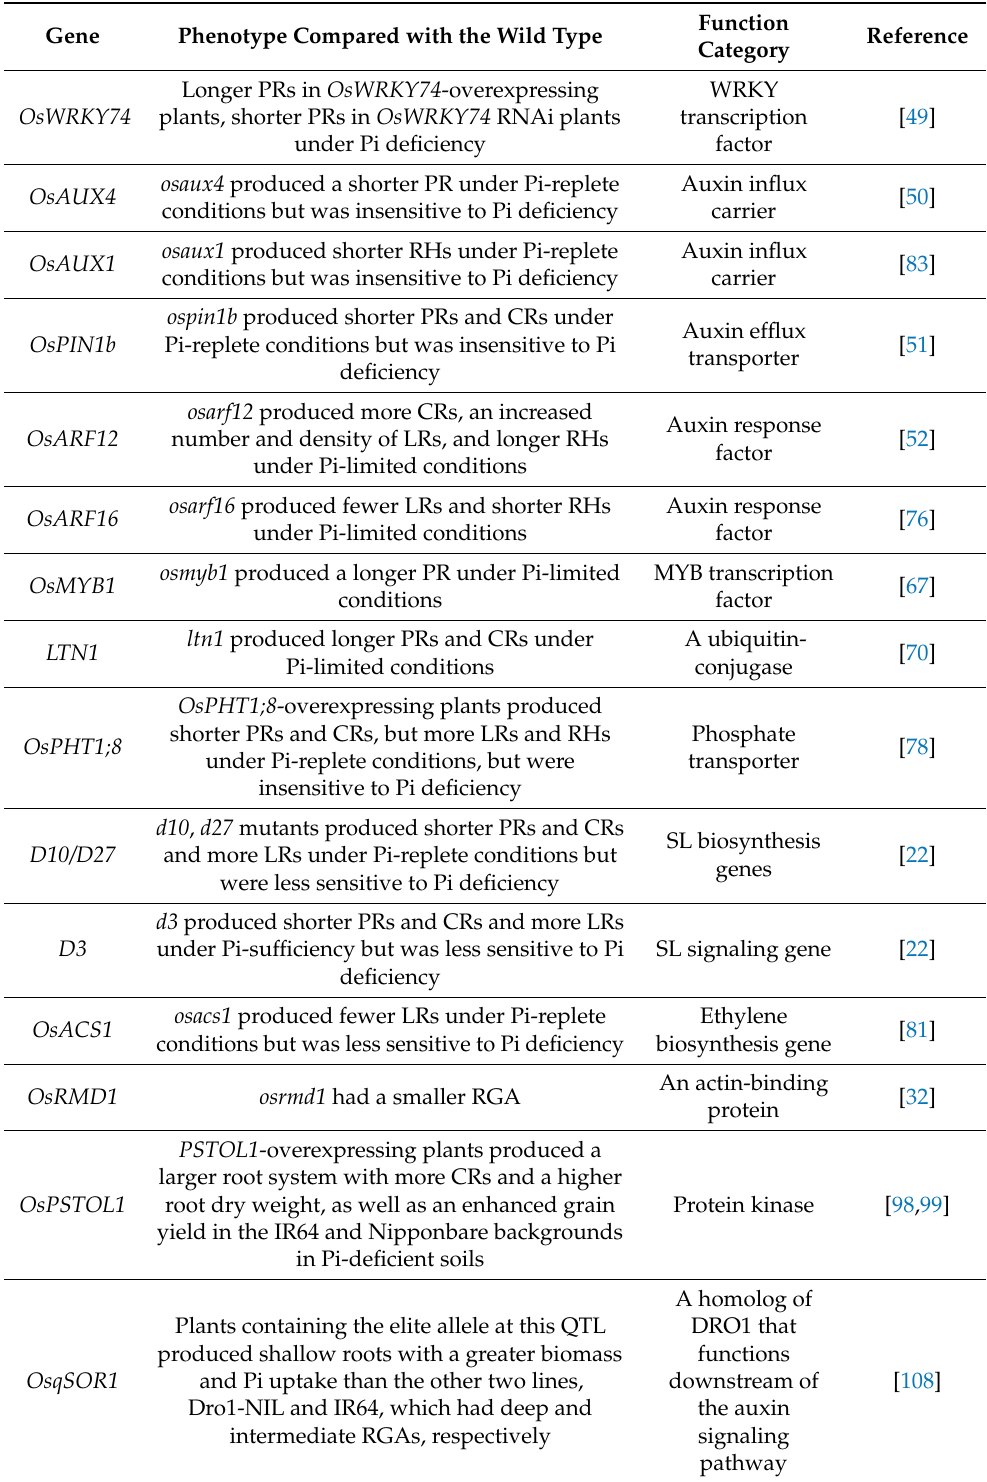
Table 1. List of known root-related genes affecting the adaptation to low Pi in rice.